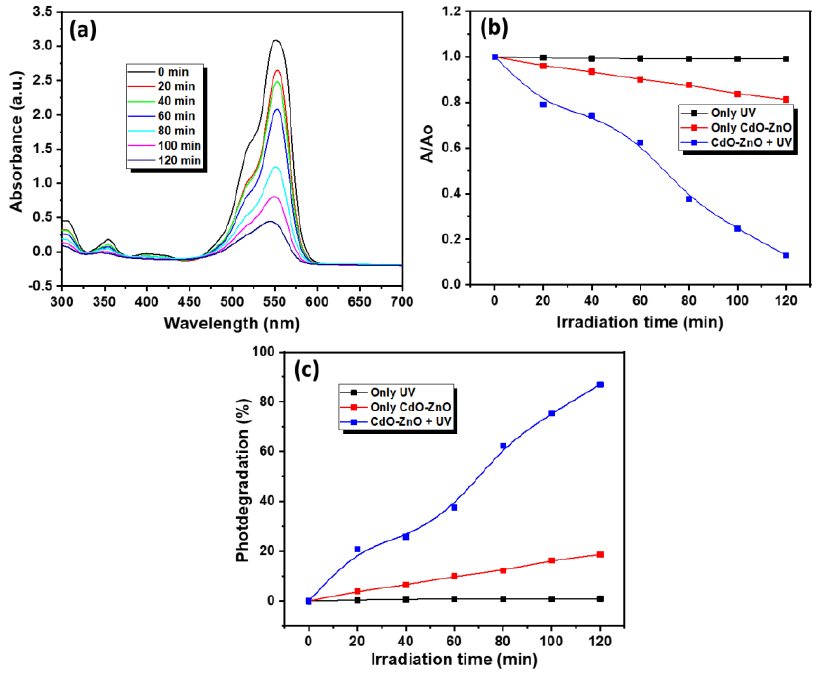
Figure 3. ( a ) UV-Visible spectra, ( b ) variations in decomposition (A/A o ), and ( c ) variations in percentage degradation of the RhB dye solution containing 0.05 g of CdO-ZnO nanocomposites as photocatalysts at different intervals.